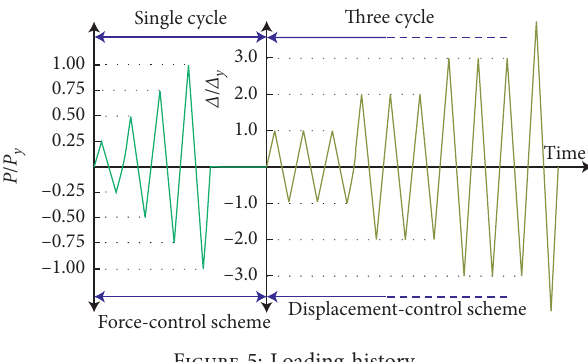
Figure 5: Loading